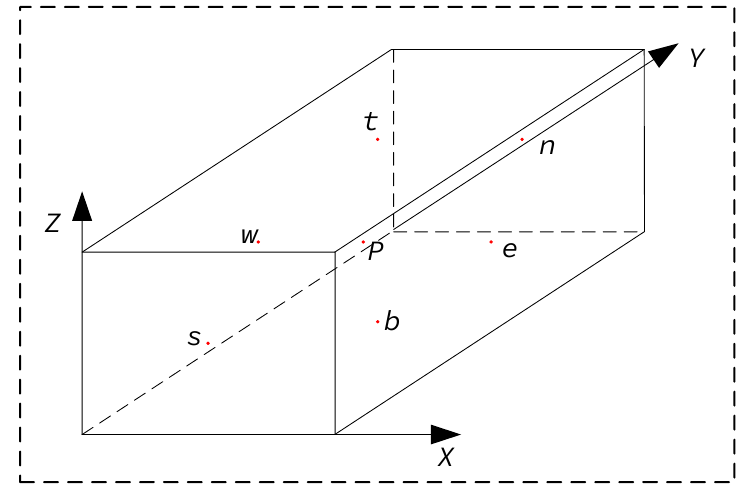
Figure 2. The 3D schematic diagram of the rectangular type finite small volume cell. According to the law of energy conservation and Fourier’s law of heat conduction, the general form of the differential equation for a three-dimensional active steady-state heat thermal conductivity model with an internal heat source [31] can be defined as